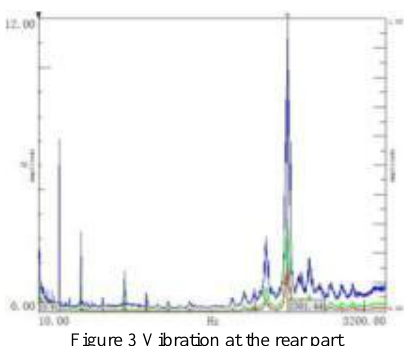
Figure 3 Vibration at the rear